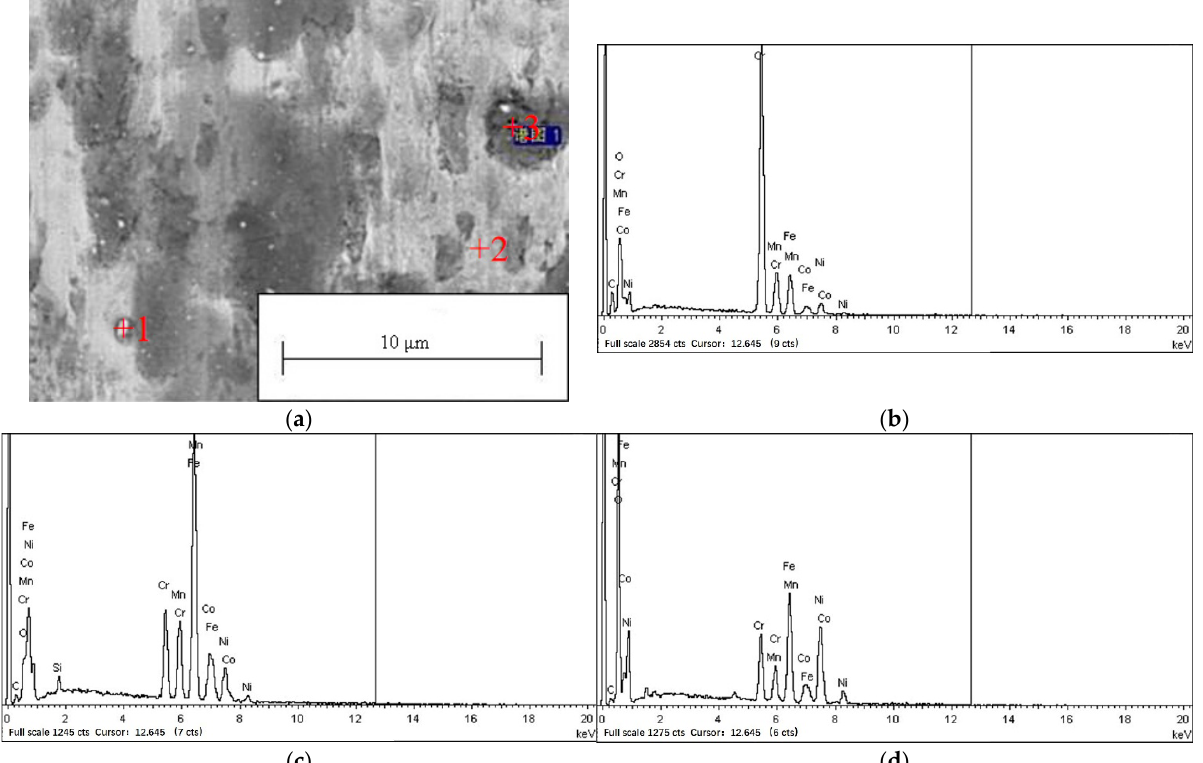
Figure 14. Point analysis of elements in the CoCrFeNiMn HEA coating prepared at 55 A plasma arc currents after the friction wear test ( a , b ) spectra at point 1, ( c ) spectra at point 2, ( d ) spectra at point 3.